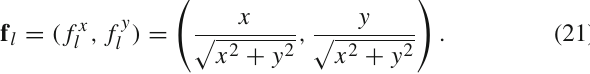
the PPL and the bottle row is for the PPM. In each row, the coupling parameter α from left to right is taken to − 0 . 4, − 0 . 2, 0, 0 . 2 and 0 . 4, respectively. Here, we set M =